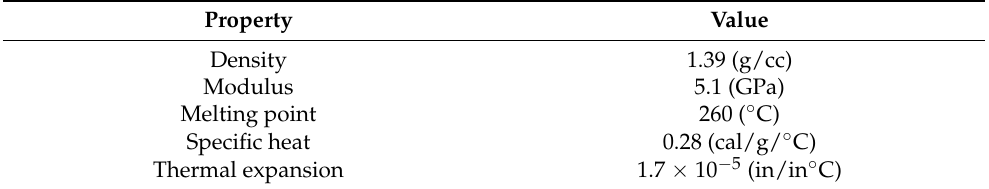
Table 2. The polyester substrate